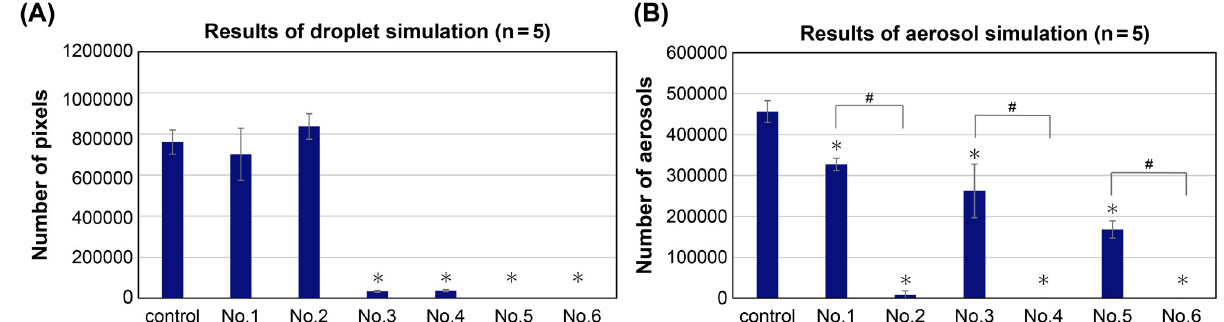
Fig 4. Results of the droplet and aerosol simulations. Experimental evaluation was performed under the following device configurations: control—no mask; No. 1—wearing a mask without a rubber slit (for surgery) without suction; No. 2—wearing a mask without a rubber slit (for surgery) with suction; No. 3—wearing a mask with a rubber slit (for outpatients) without suction; No. 4—wearing a mask with a rubber slit (for outpatients) with suction; No. 5—wearing a mask with a rubber slit (for outpatients) and using an insertion sleeve for the endoscope without suction; No. 6—wearing a mask with a rubber slit (for outpatients) and using an insertion sleeve for the endoscope with suction. (A) The average number of black pixels, representing droplets ( n = 5). (B) The average number of aerosols ( n = 5). � P < 0.05 vs. control. # P < 0.05 between devices used with suction and those used without suction. Statistical analysis was performed using the Mann-Whitney U